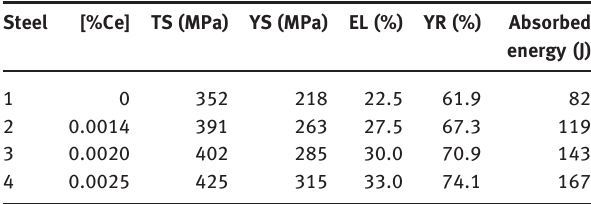
Table 3: Tensile and impact properties of various steels. Steel